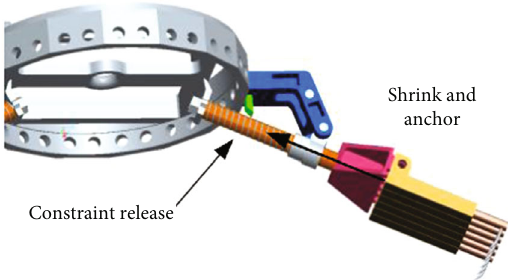
Figure 8: Poststatus.